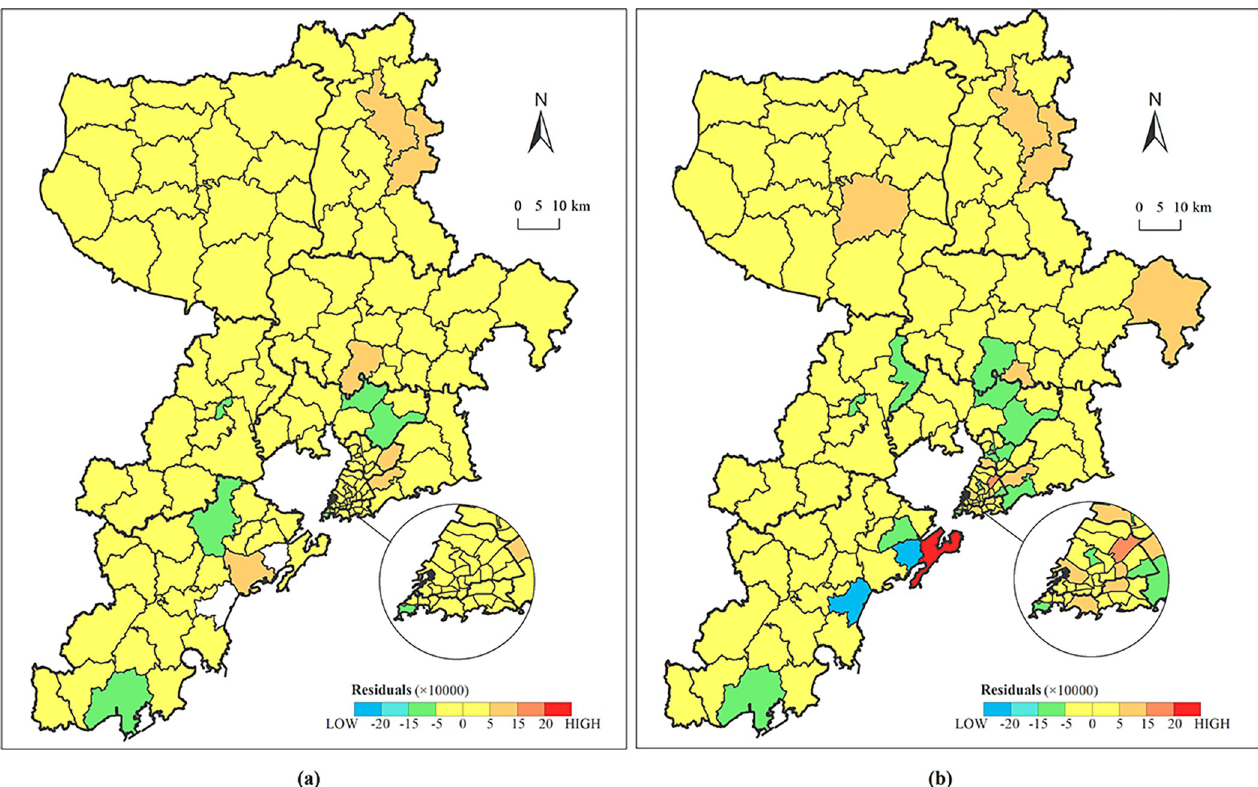
Fig 12. Residual distribution of estimated population between (a) POP est and (b) Worldpop datasets and real statistics.